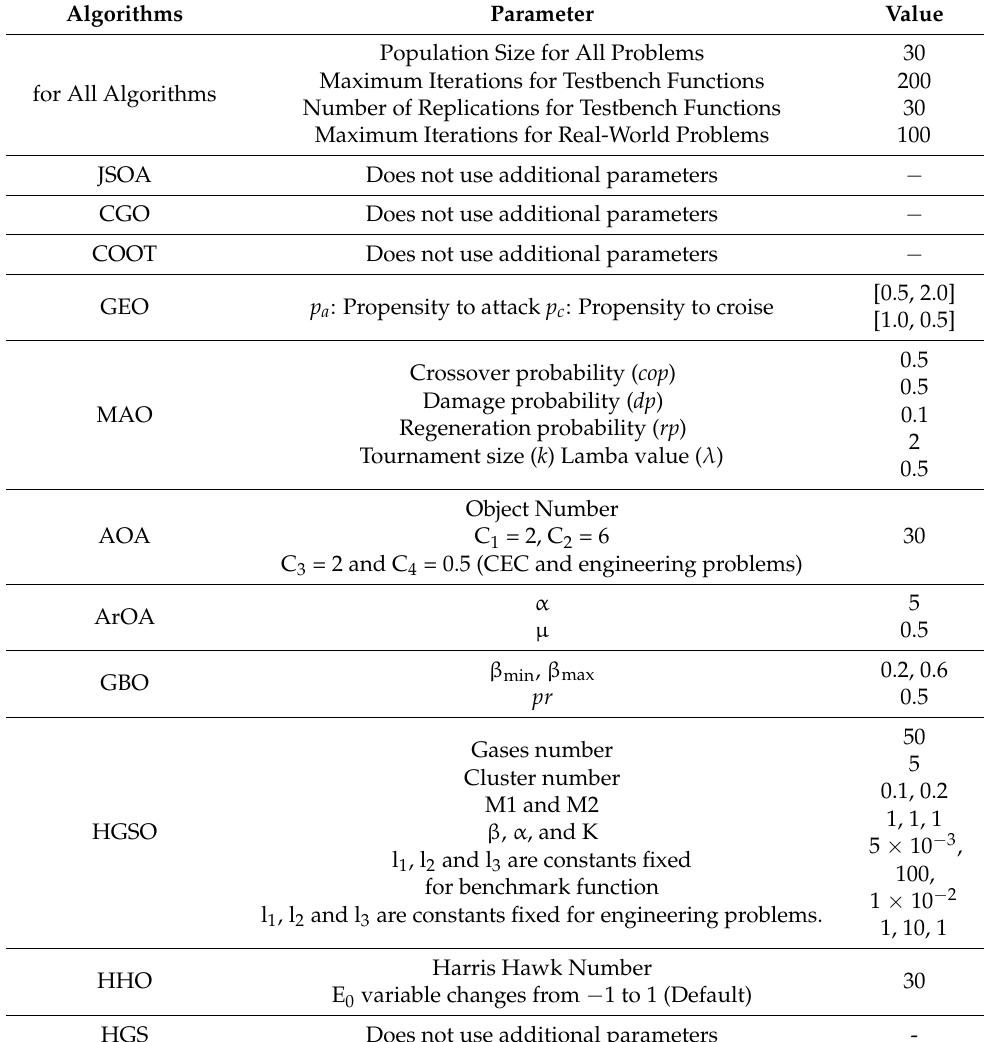
Table 1. Parameter